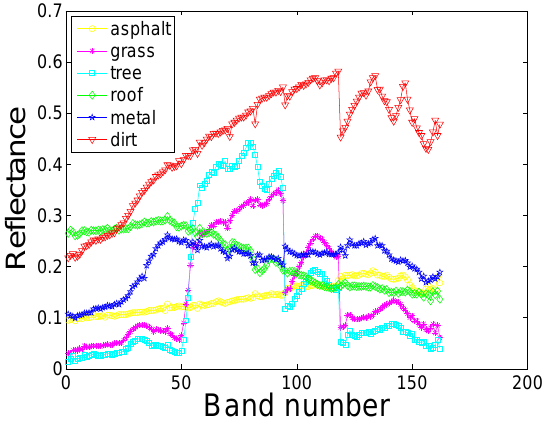
Figure 10. Endmembers of